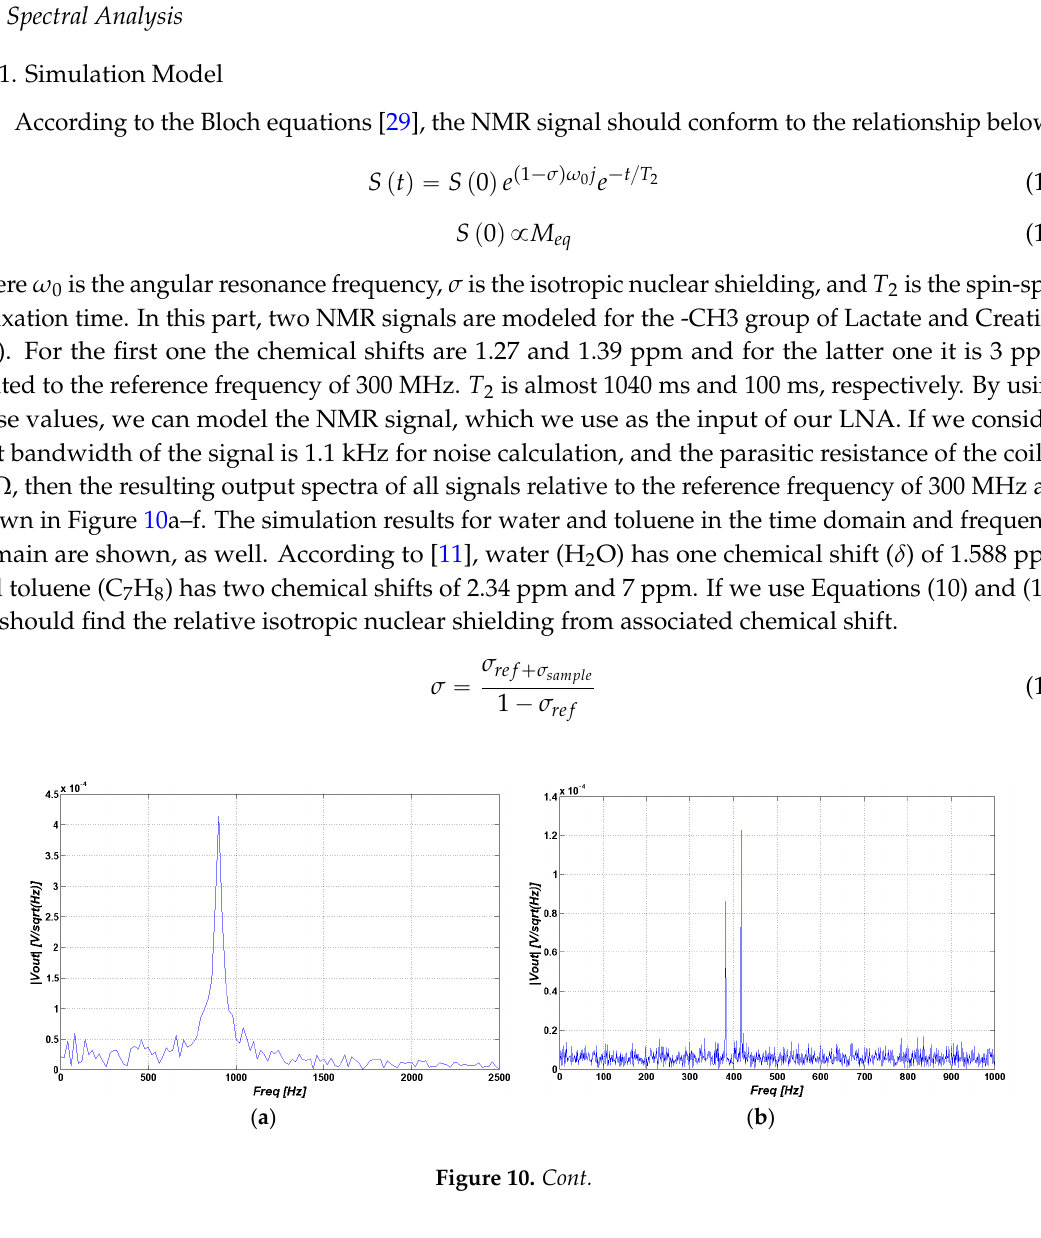
Table 1. CMOS Chip